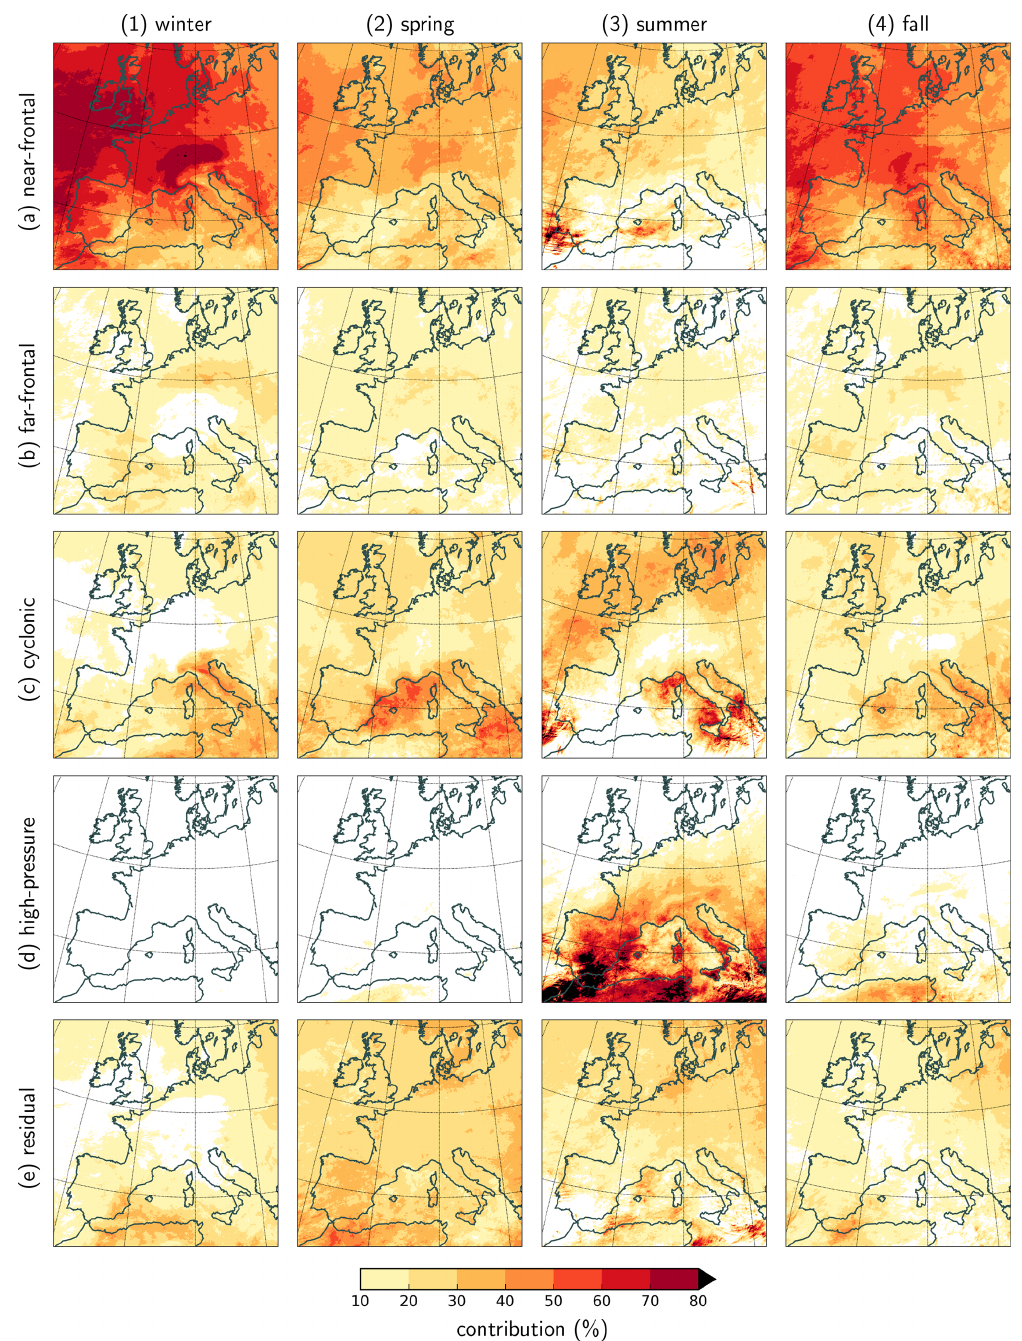
Figure 9. Relative precipitation contributions during (1–4) each season of the 9-year period 2000–2008 of front–cyclone-relative components: (a) sum of cold-frontal, warm-frontal, and collocated; (b) far-frontal; (c) cyclonic; (d) high-pressure; and (e) residual.